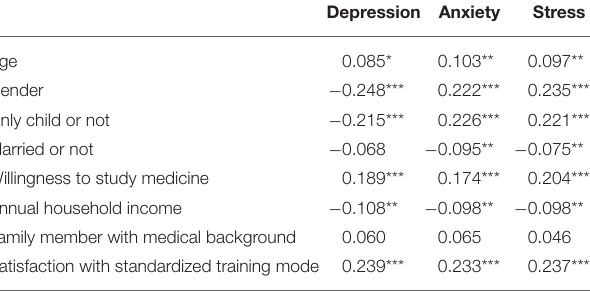
TABLE 3 | Correlation analysis.